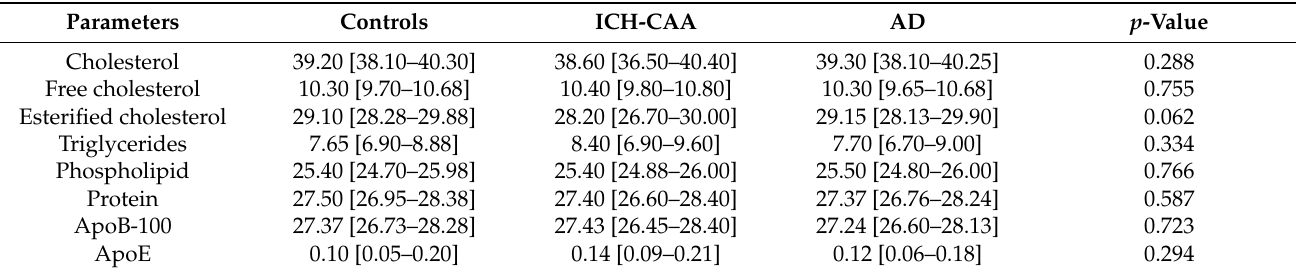
Table 4. LDL composition.